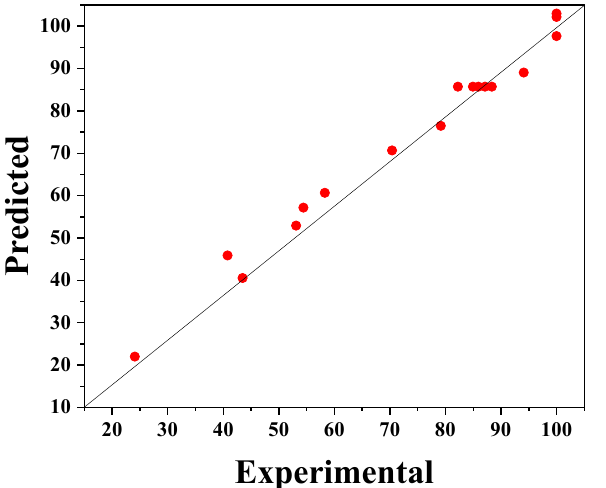
Figure 6. The experimental phenol degradation efficiency (%) plotted against the predicted values from the RSM model.